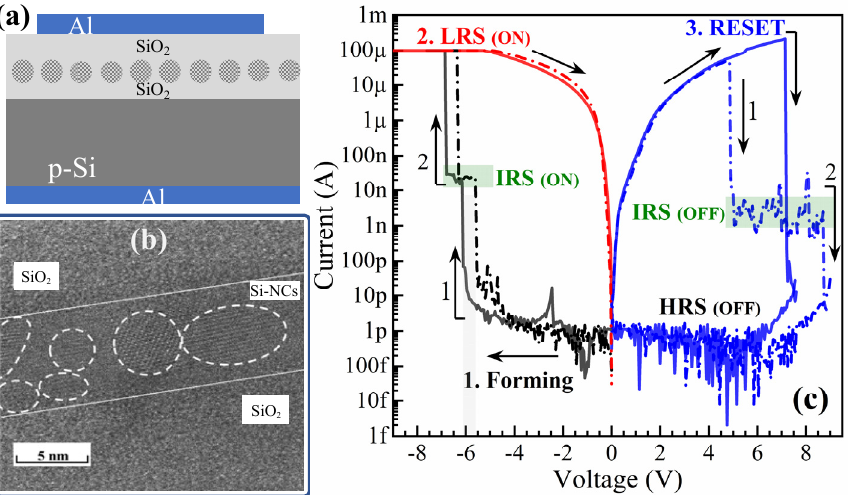
Figure 1. ( a ) Schematic of the MOS-like structure (not at scale); ( b ) cross-sectional TEM image of the SiO 2 /Si-NCs/SiO 2 device; and ( c ) typical I-V curves of bipolar resistive switching. During forming and RESET process, an intermediate resistive state (IRS) is observed.